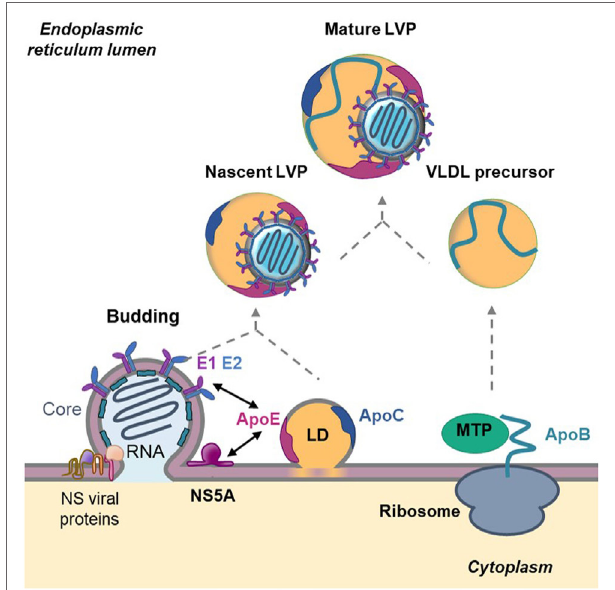
FigURe 3 | Role of apolipoproteins in hepatitis C virus (HCV) morphogenesis. HCV assembly takes place at the surface of endoplasmic reticulum (ER)-derived membranes in close proximity to lipid droplets (LD). Core protein associates with viral RNA to form the nucleocapsid. The nucleocapsid buds at the ER membrane where E1 and E2 glycoproteins are anchored and afterward associate with nascent LD to acquire ApoE and ApoC. This step is facilitated by the interaction between ApoE and the non-structural (NS) viral protein NS5A as well as by the interaction between ApoE and the glycoproteins E1 and E2. In parallel, ApoB is lipidated by the microsomal triglyceride transfer protein (MTP) to generate very-low density lipoprotein (VLDL) precursors. The nascent HCV particle associates with these precursors by an unknown mechanism to generate mature lipo-viro-particles